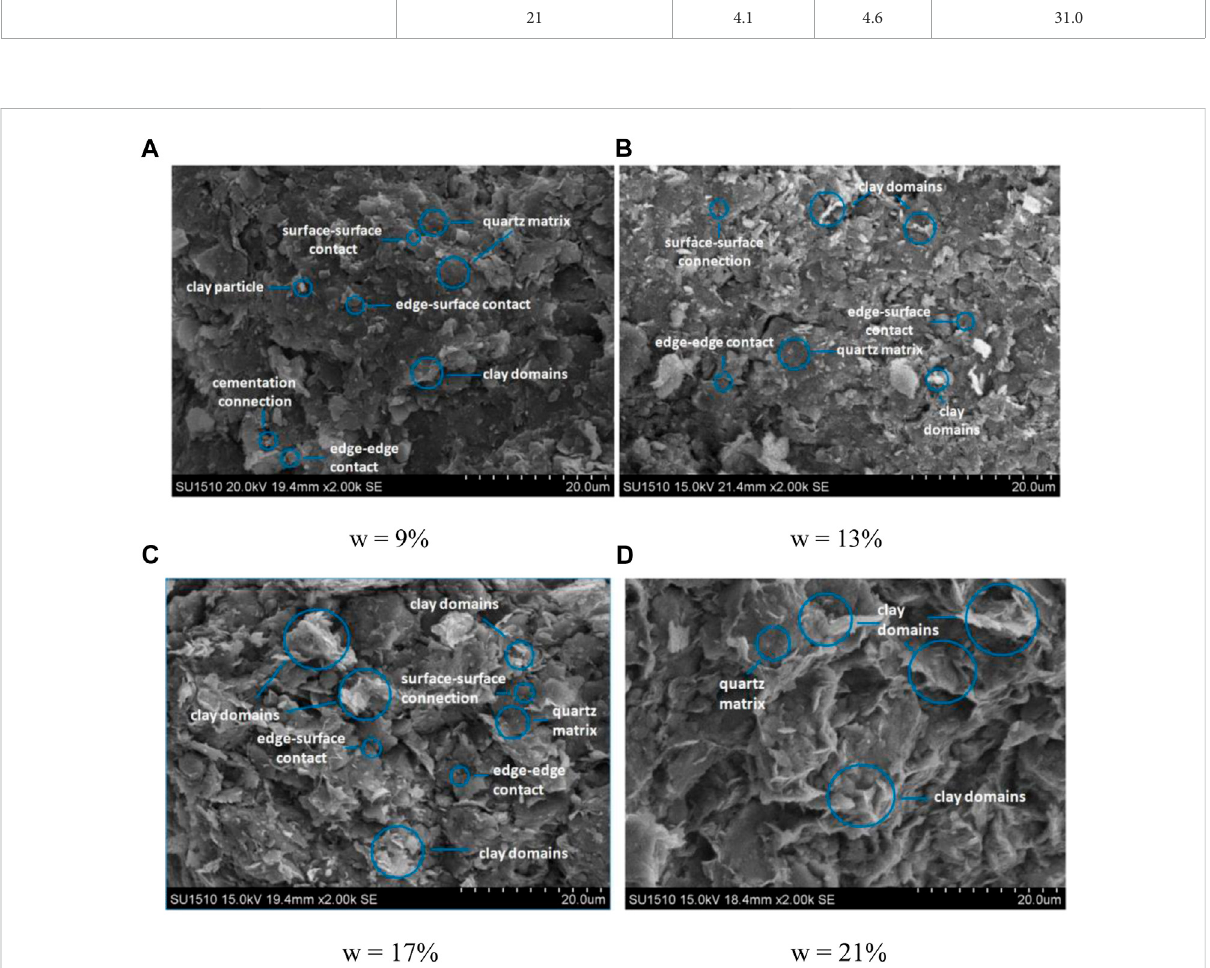
FIGURE 5 The 0 DWC microcosmic structures of the CBS with the different moisture contents. (A) w = 9% (B) w = 13% (C) w = 17% (D) w =